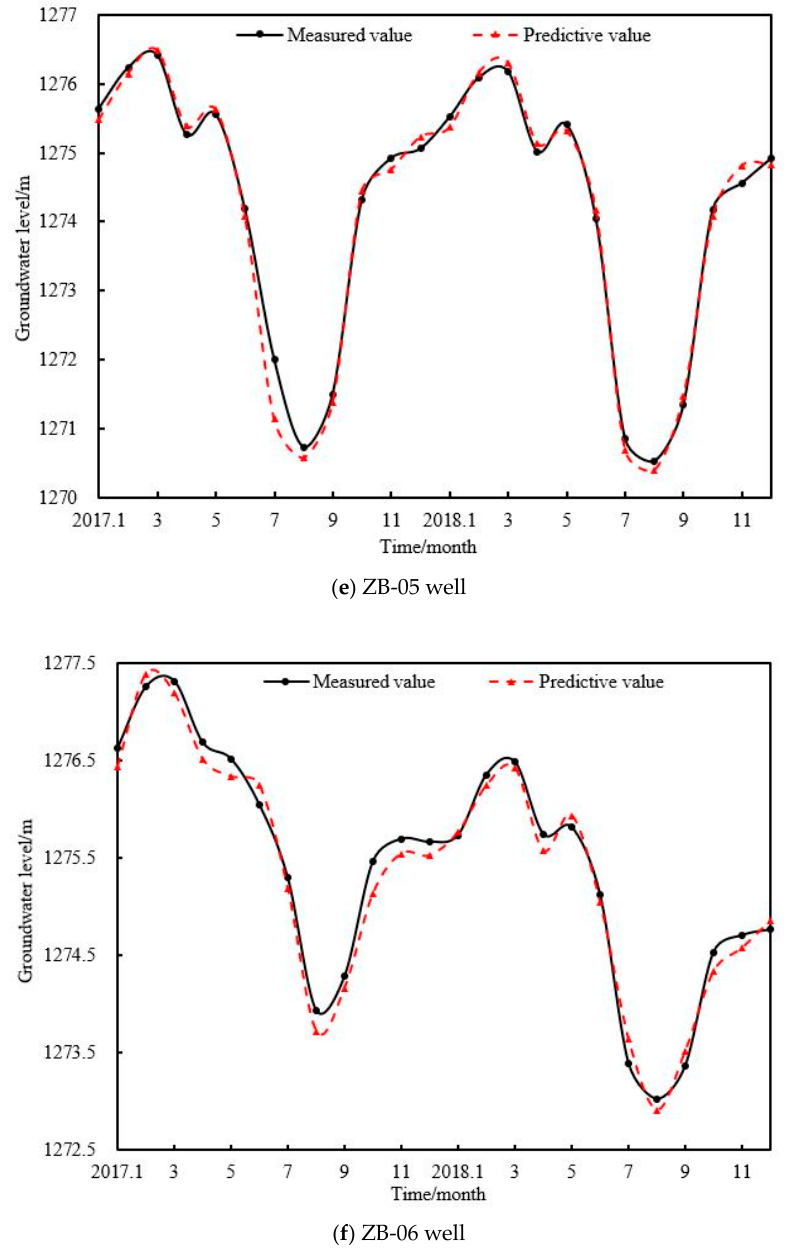
Figure 8. Fitting curve of the measured and predicted values of six monitoring wells obtained using the ABC-BP model.